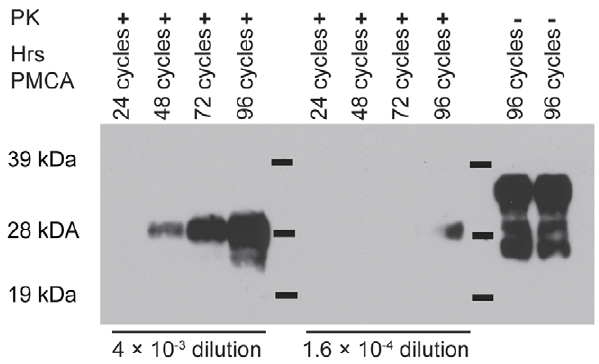
Figure 5. Kinetics of CWD amplification using PMCAb. Four 10 m L samples of 4 6 10 2 3 or 1.6 6 10 2 4 dilutions of CWD-positive BH (10%) were added to 90 m L NBH containing 0.05% saponin and subjected to PMCAb for the indicated number of